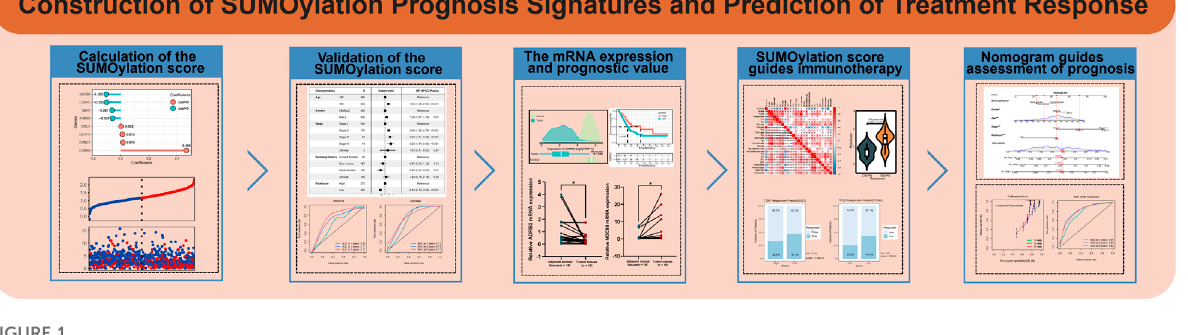
FIGURE 1 Flow chart of our